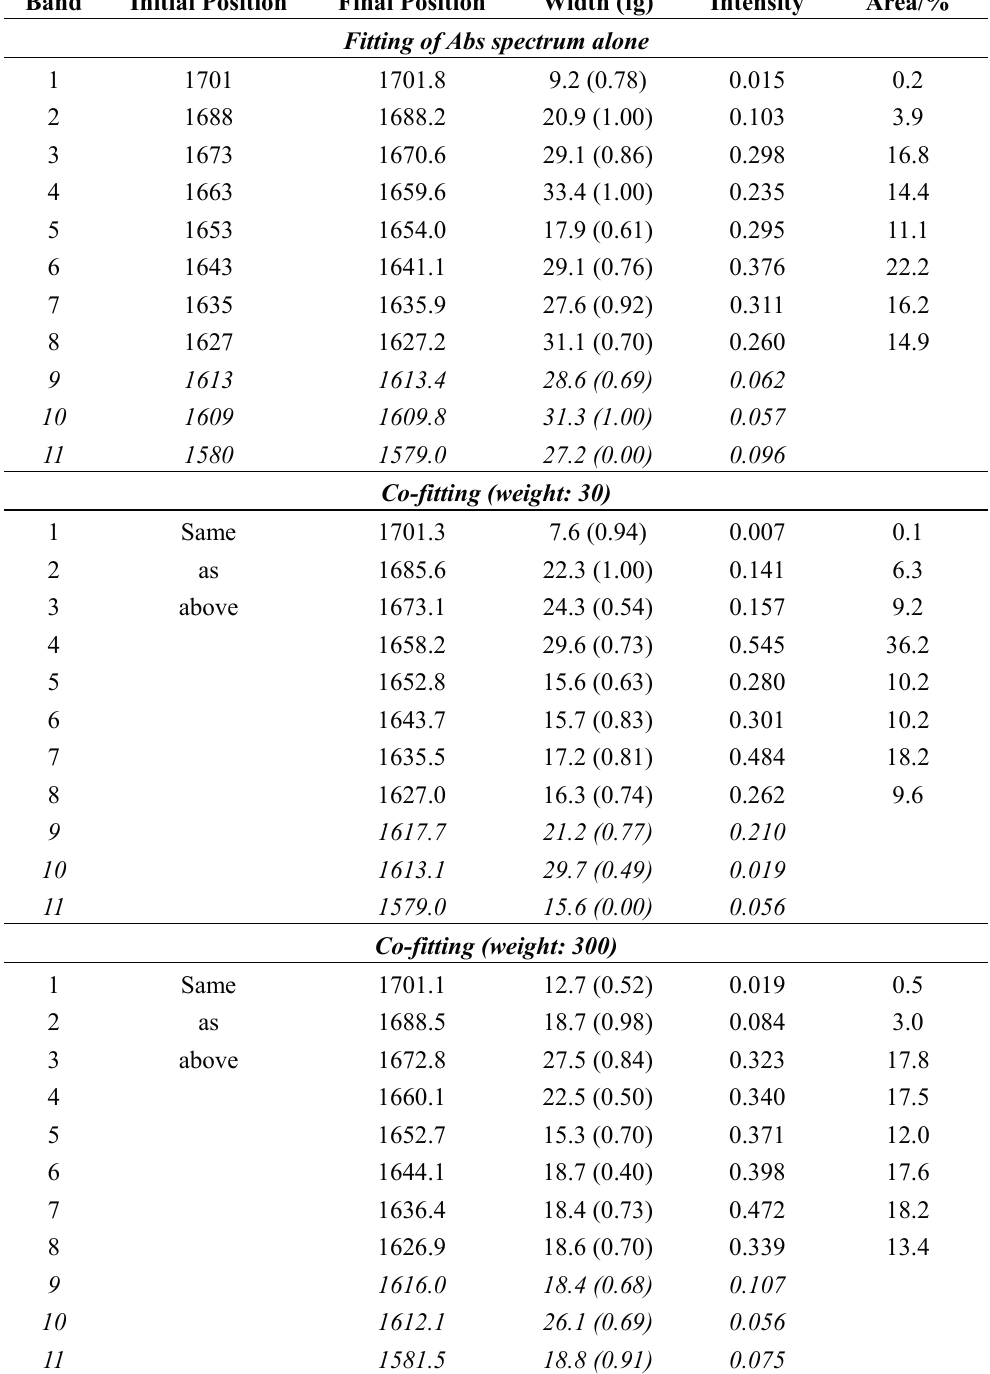
Table 3. Band parameters obtained upon standard fitting and co-fitting of pyruvate kinase. Values in italics correspond to amino acid side chain absorptions and where excluded from calculation of band area of the amide I band. The fg values denotes the fractional contribution of the Gaussian lineshape to the overall lineshape. The initial value was 0.50 for all